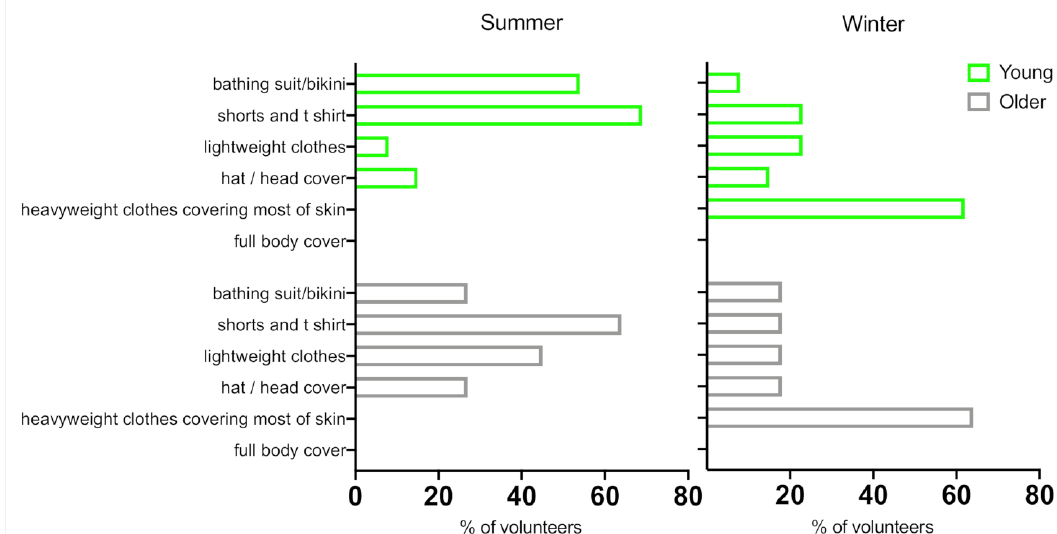
Figure 4. Normal clothing worn during the day whilst on summer and winter holidays by younger and older volunteers.